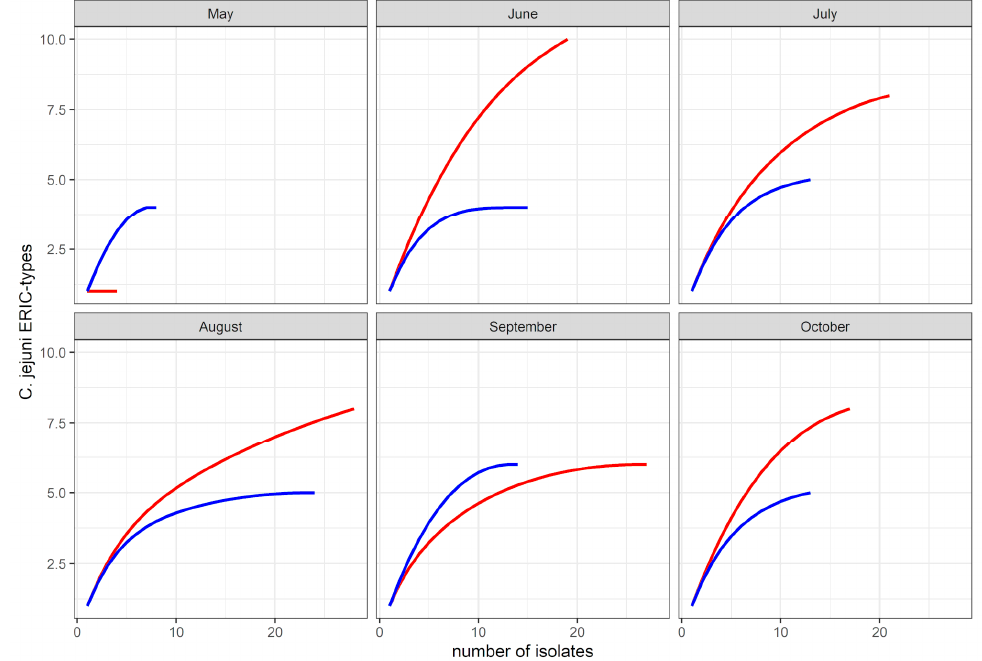
Figure 1. Rarefaction curves of C. jejuni population in cow faeces (blue) and wild bird droppings (red) during the study period.